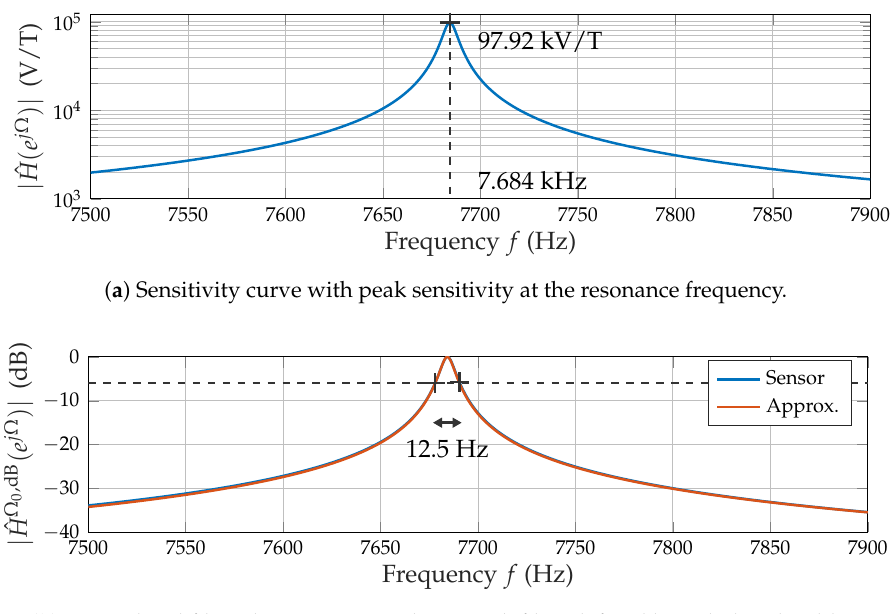
Figure 3. Frequency response of the ME sensor. The sensitivity curve (Figure 3a) results from multiple discrete measurement points interpolated using a spline method. The data were obtained using a magnetic sine sweep at a peak amplitude of 100 nT. The peak sensitivity (approximately 100 kV/T) is reached at the resonance frequency (approximately 7.684 kHz). The filter characteristic (Figure 3b)